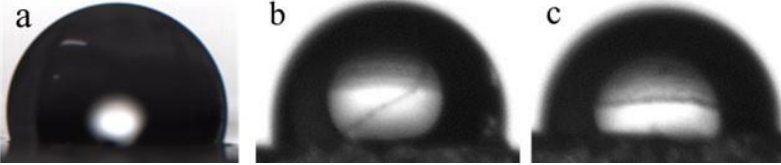
Figure 7. Water contact angles of S05 coatings with different scouring time ( a ) 0 h, ( b ) 20 h, and ( c ) 40 h.